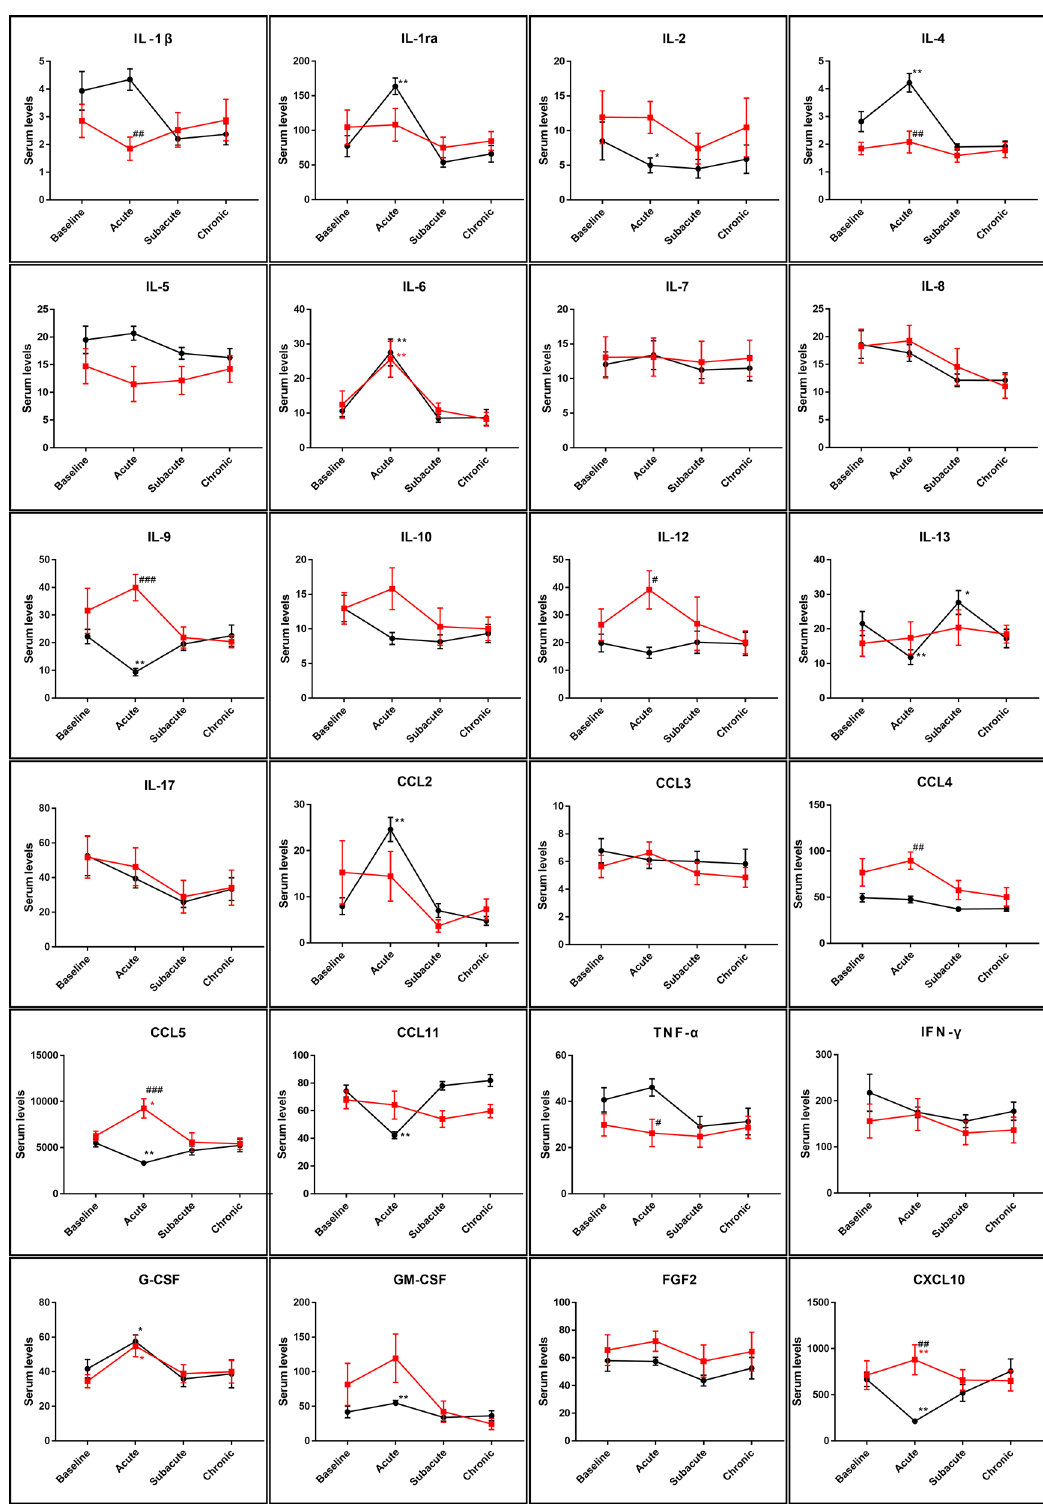
Figure 2. Changes in systemic cytokines in patients with or without cell sheet engraftment. Cytokines were measured before ESD, during acute phase, at subacute phase and in chronic phase after ESD. Black line represents the results from patients without cell sheet and red line represents the results from patients with cell sheet. Bars indicate average ± SEM. Dunnett test compared to baseline: *p < 0.05; **p < 0.01; Welch t test between patients with and without cell sheet: # p < 0.05; ## p < 0.01; ### p <